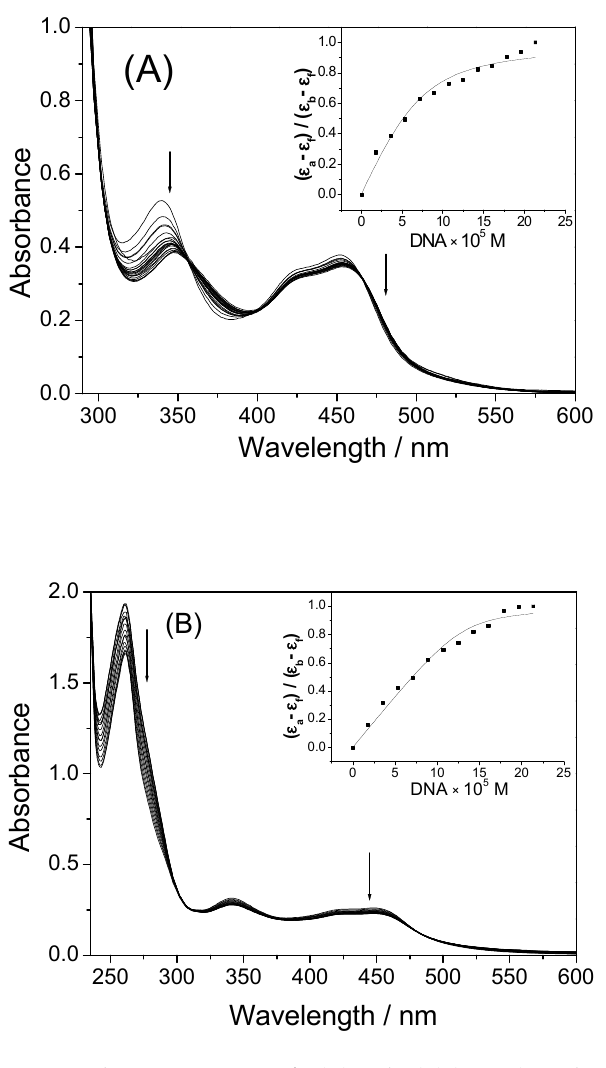
Figure 1. Absorption spectra of 1 ( A ) and 2 ( B ) (20 µ M) incubating various concentrations of ct-DNA. Inset: plots of ( ε a − ε f ) / ( ε b − ε f ) vs. DNA.